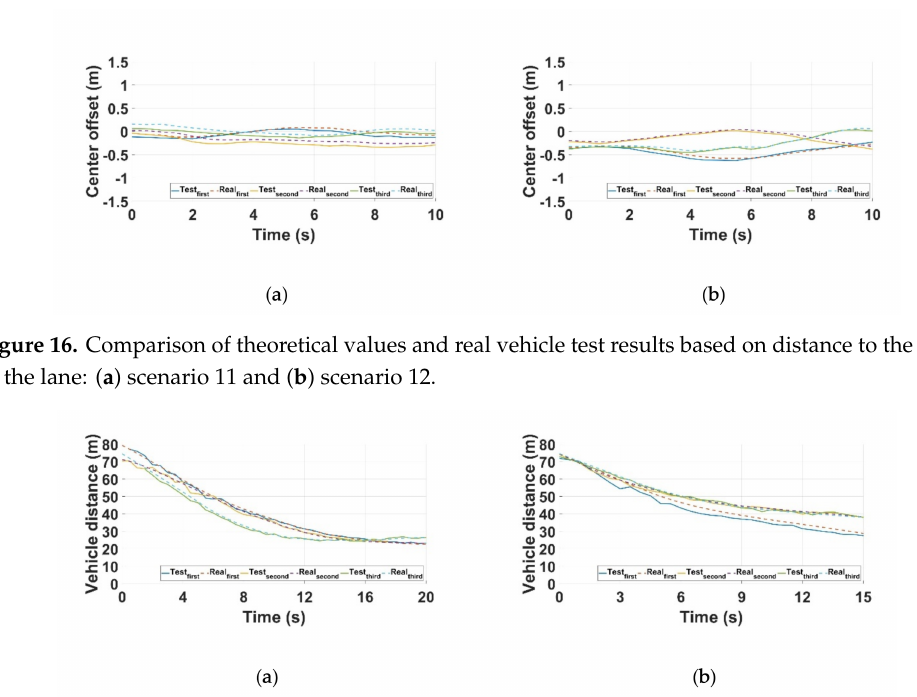
Figure 17. Comparison of theoretical values and real vehicle test results based on distance to the lead vehicle: ( a ) scenario 6 and ( b ) scenario 8.